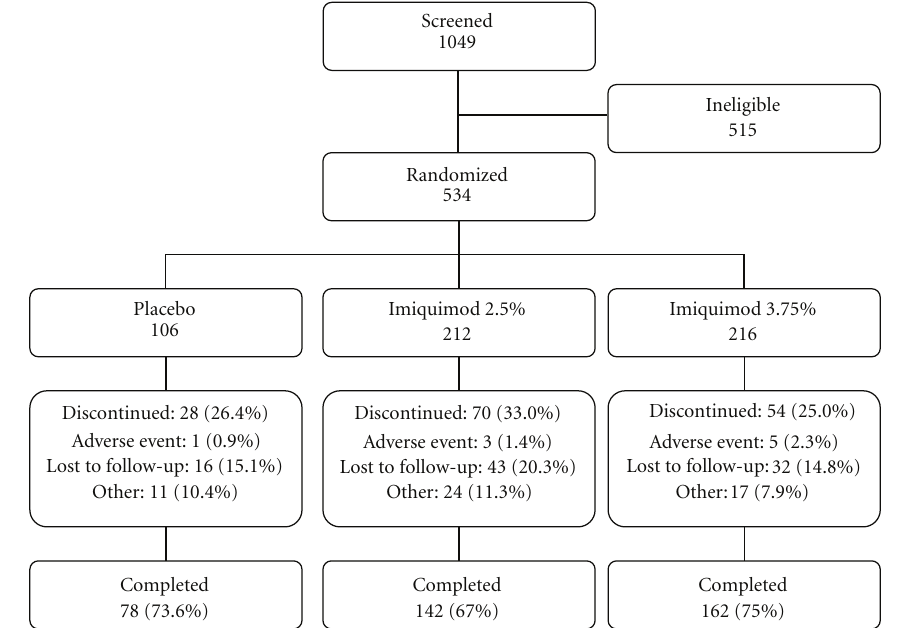
Figure 1: Disposition of women in the studies, combined, evaluation phase. Percents displayed are percent of women randomized by treatment group. Adverse events category includes women discontinuing for local skin